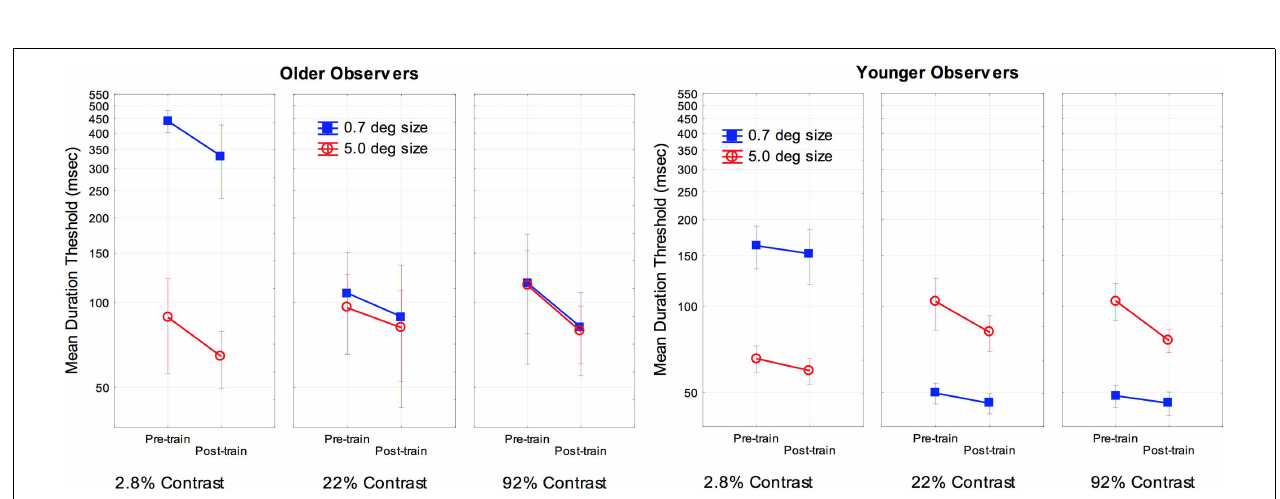
FIGURE 2 | Effects of training, size, contrast, and age on motion duration thresholds. Error bars represent ± 1 SE.